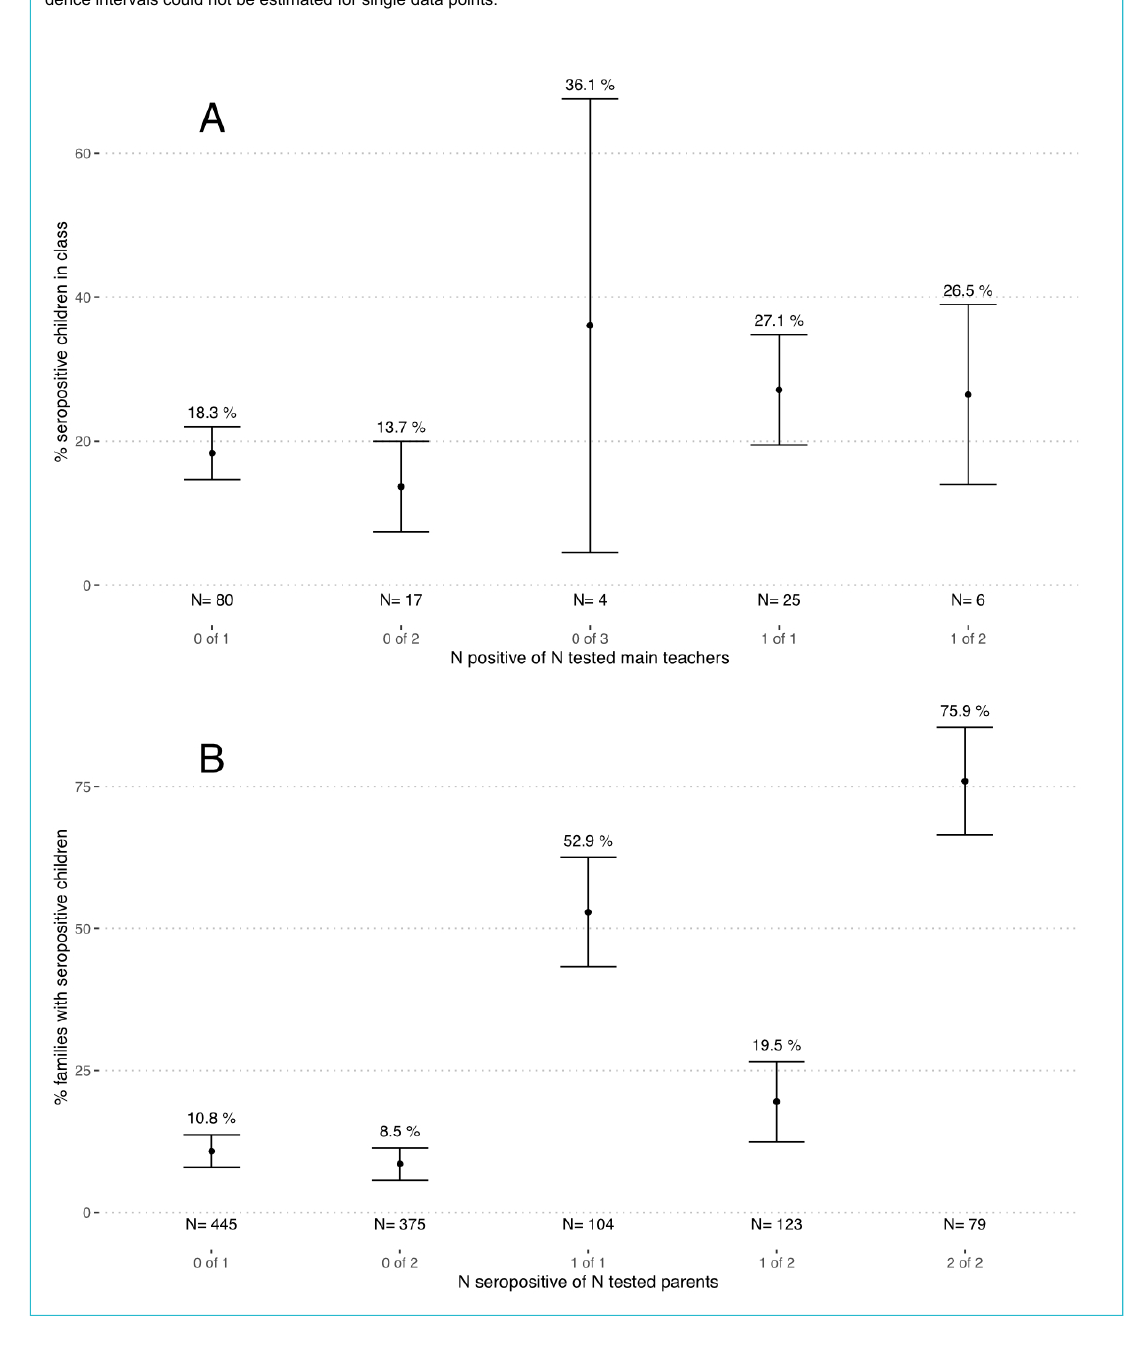
Figure 3: Proportion of seropositive children in classes and families depending on the number of tested and seropositive main teachers and parents in March-April 2021. A – Classes with at least one main teacher and 4 children tested. Numbers (N) below graphs correspond to the numbers of classes in the category. B – Families with at least one child and one parent tested. Numbers (N) below graphs correspond to the numbers of families in the category. Note: The name of the category, written in grey below the number of classes or families tested, tells how many teachers (parents) were tested in a class (family) from the total tested within that class (family). E.g., “0 of 1” signifies classes where a single main teacher was tested, with the test result seronegative. We do not show two classes with 3 main teachers tested because confi- dence intervals could not be estimated for single data